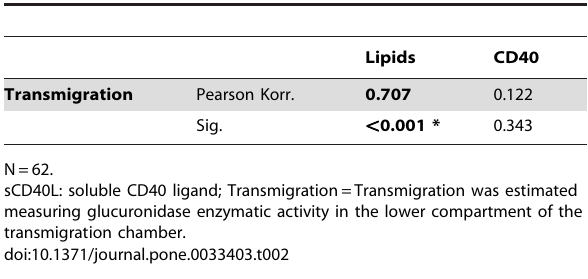
Table 2. Correlation of transendothelial migration of neutrophils with baseline sCD40L and lipid concentration in blood